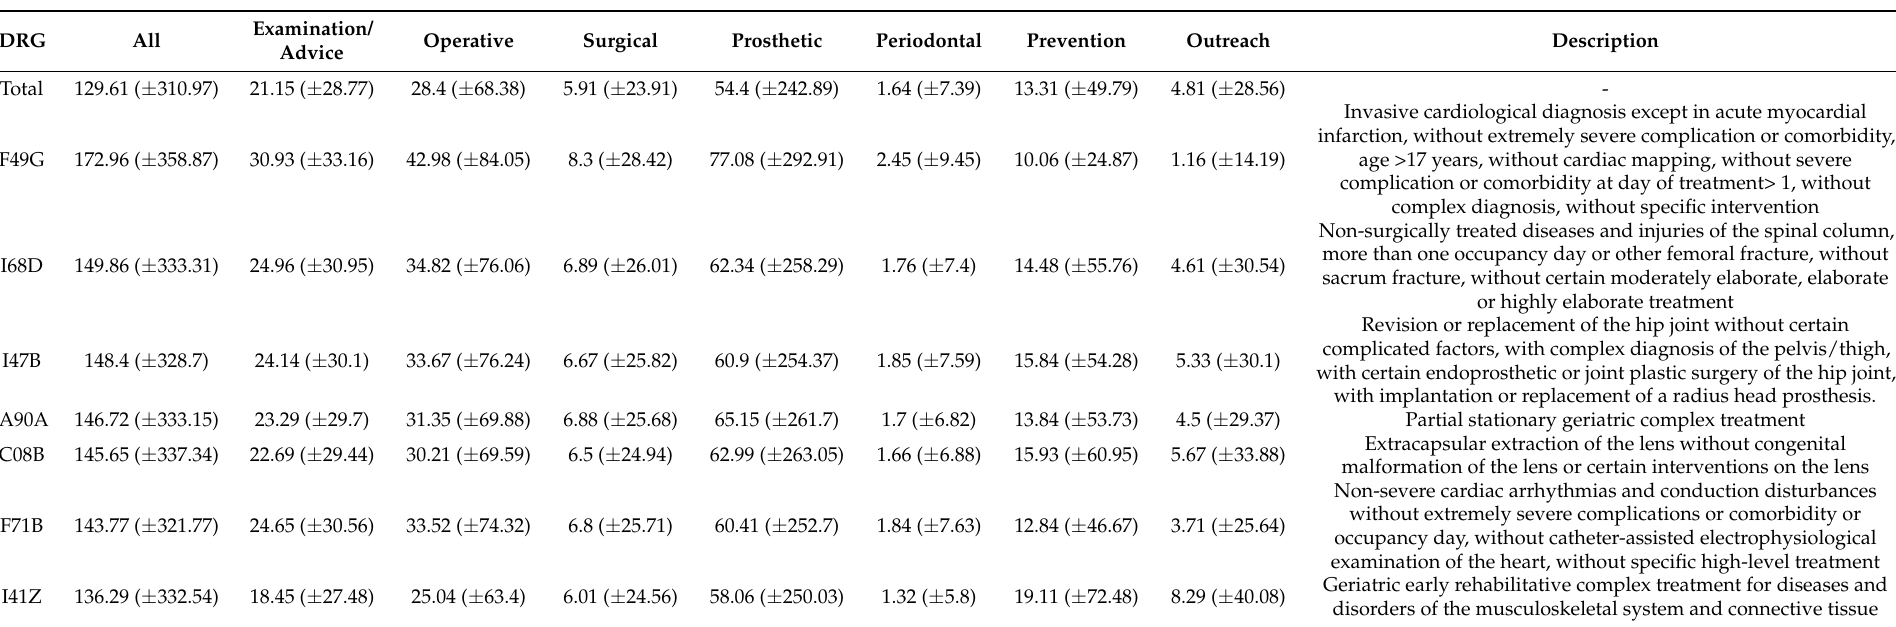
Table 3. Costs for dental services for the very old in Northeast Germany according to German Modified Diagnosis Related Groups (DRGs). All and service-specific mean ( ± SD) costs are shown for the total population and the population with specific